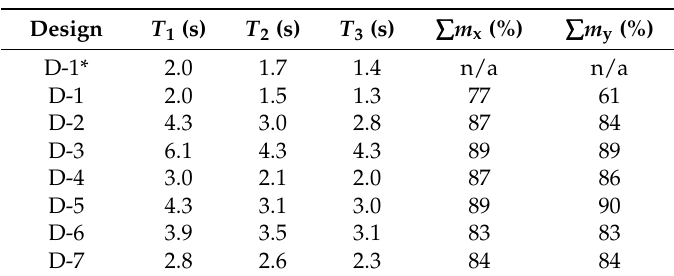
Table 2. Results from modal analyses.